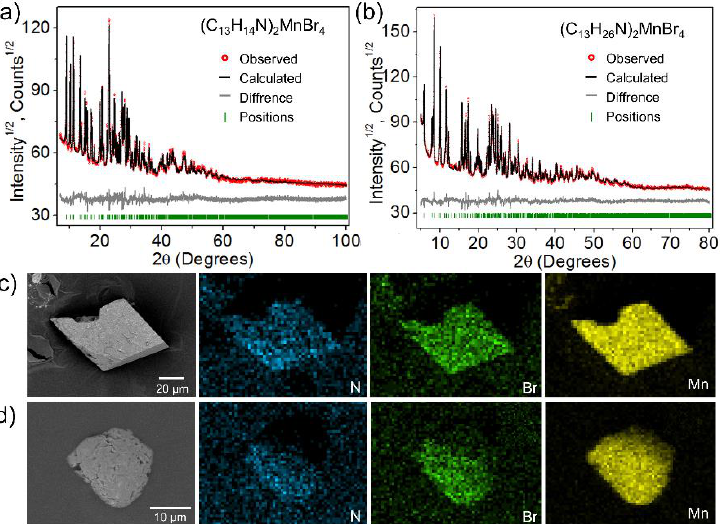
Figure 2. Rietveld refinements of PXRD patterns for ( a ) (C 13 H 14 N) 2 MnBr 4 , ( b ) (C 13 H 26 N) 2 MnBr 4 . SEM images and EDS elemental mapping images showing the homogeneous distribution of N, Mn and Br in compounds for ( c ) (C 13 H 14 N) 2 MnBr 4 and ( d ) (C 13 H 26 N) 2 MnBr 4 .